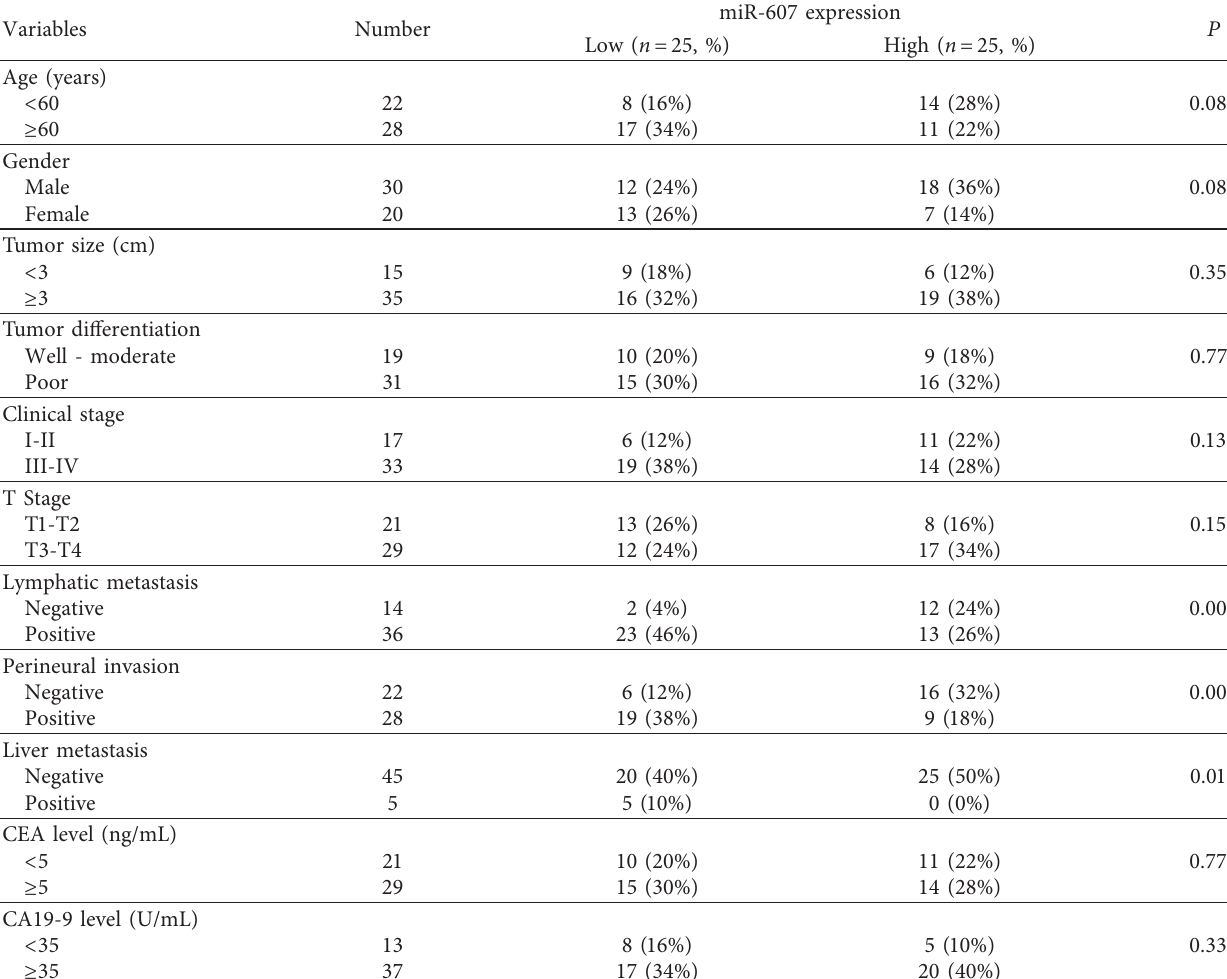
Table 1: Relation between miR-607 expression and clinicopathological characteristics of PDAC